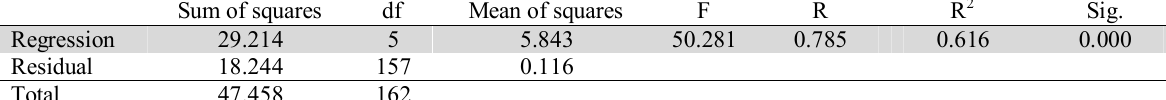
The summary of ANOVA test on relationship between emotional intelligence and job burnout Sum of squares df Mean of squares F R R 2